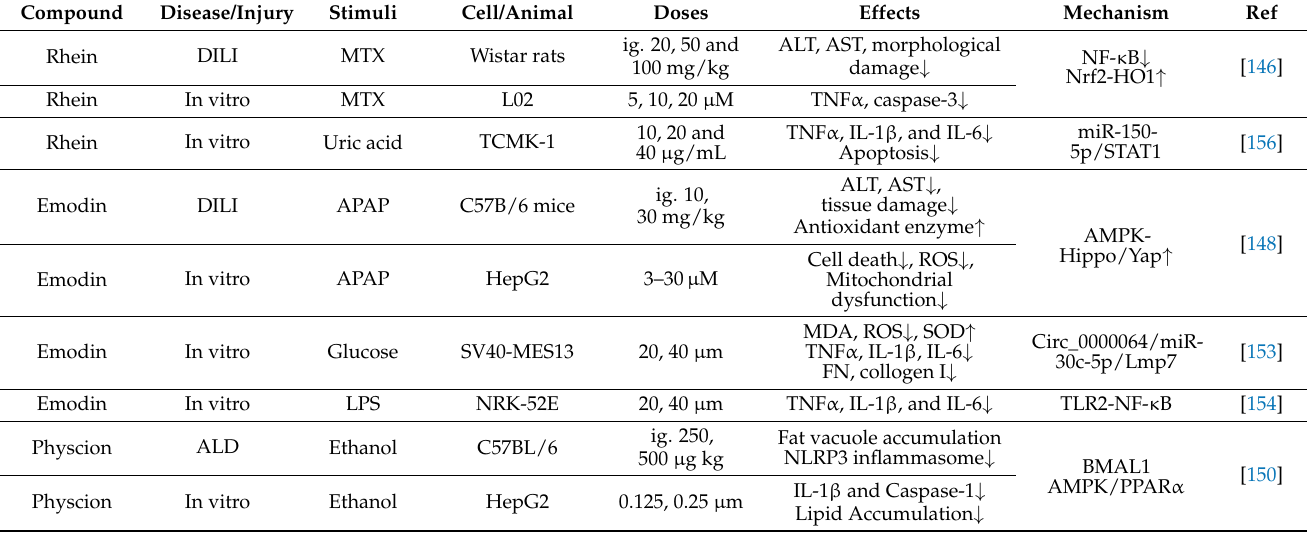
Table 7. Effects and mechanism of AQs on liver and kidney